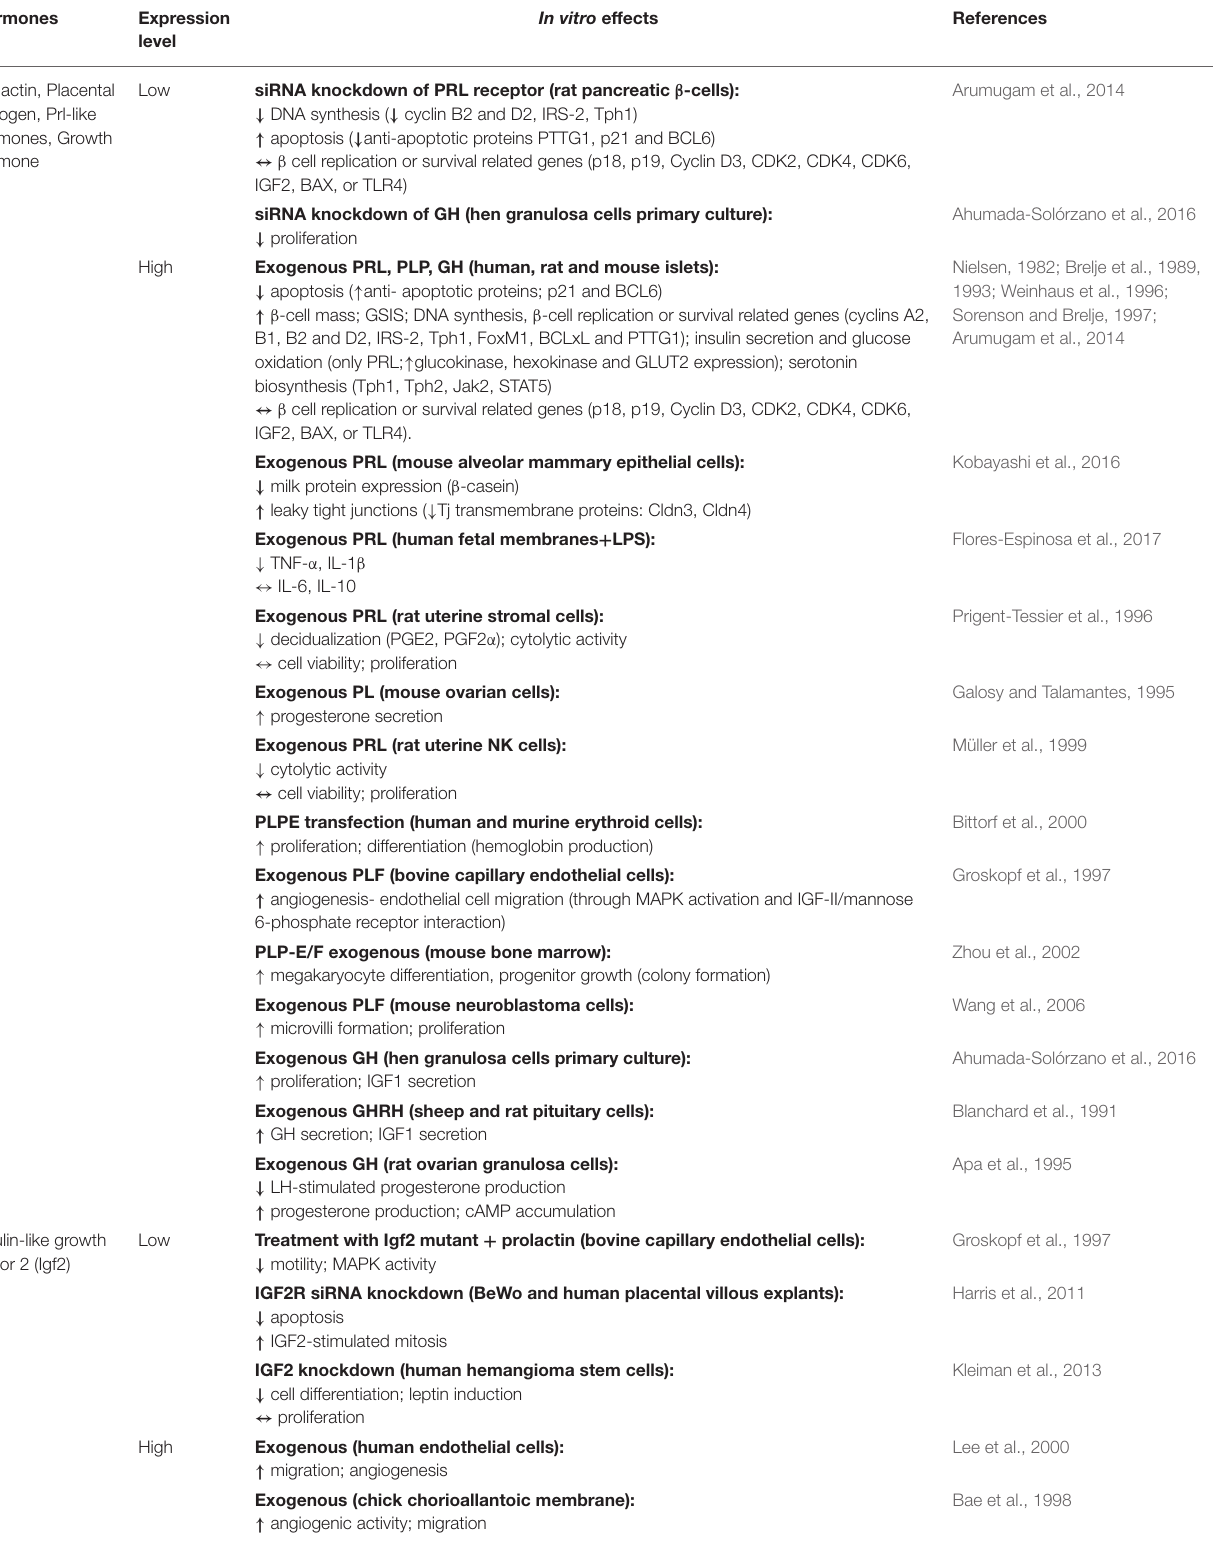
TABLE 2 | Effects of the prolactin-growth hormone family in vitro .